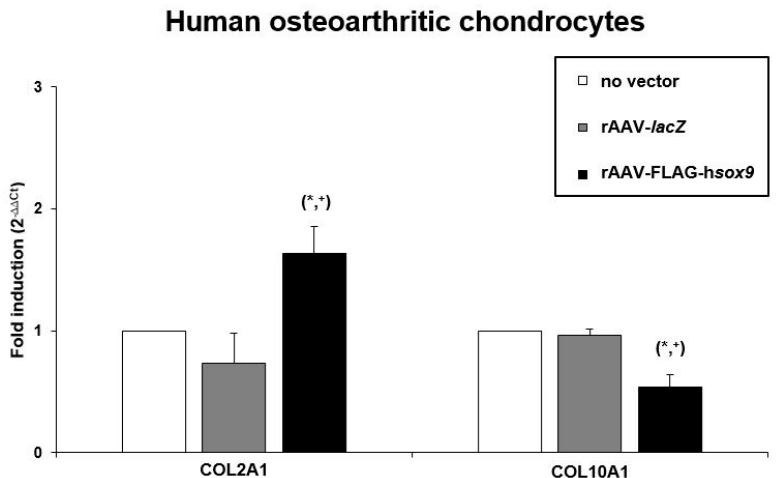
Figure 6. Real-time RT-PCR analysis in rAAV-transduced aggregate cultures of human normal and OA chondrocytes. Cell aggregates were transduced with rAAV-FLAG-h sox9 versus rAAV- lacZ (40 µ L each vector) or lack of vector treatment as described in Figures 1–5 and in the Materials and Methods. After 21 days, mRNA was directly isolated from the aggregates and the gene expression profiles of type-II collagen (COL2A1) and type-X collagen (COL10A1) were monitored, with GAPDH serving as a housekeeping gene and internal control. Threshold cycle (Ct) values were obtained for each target and for GAPDH as a control for normalization, and fold inductions (relative to the absence of vector treatment) were measured by using the 2 − ∆∆ Ct method. Statistically significant compared with *no vector treatment and + rAAV- lacZ .